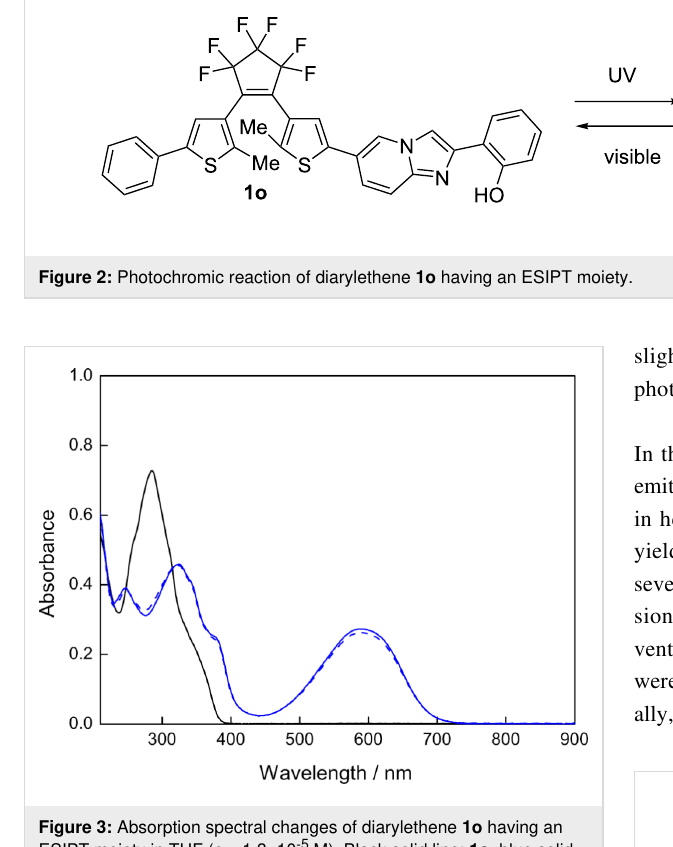
tion of the solution of 1o , the color changed to blue with in- creasing the absorption band at 587 nm of the closed-ring isomer 1c , then by visible light irradiation the color disap- peared and reproducing the absorption spectra at 285 nm of 1o .